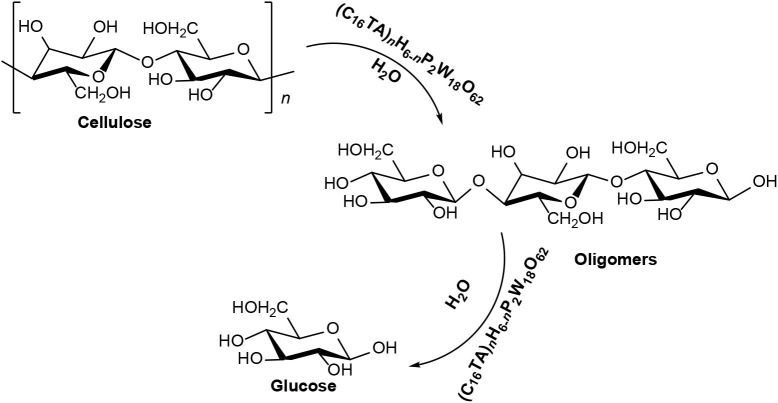
The mechanism of cellulose conversion by (C16TA)nH6−nP2W18O62 catalyst.